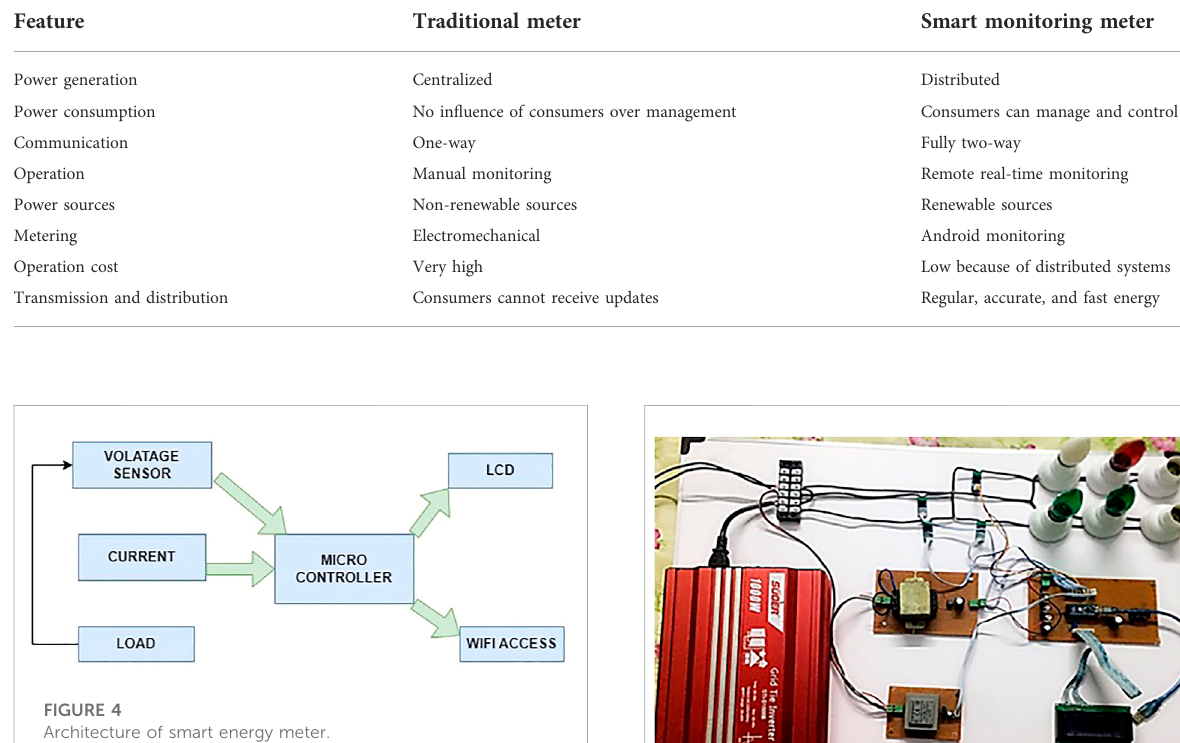
FIGURE 4 Architecture of smart energy meter.